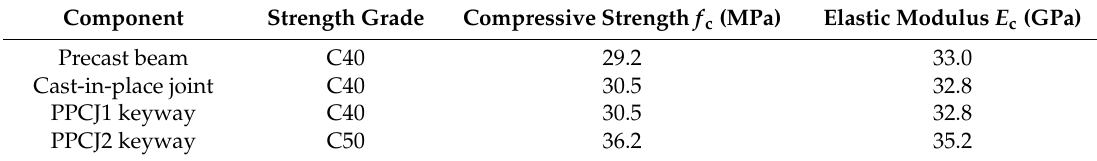
Table 1. Material properties of concrete. PPCJ—precast prestressed concrete joint.